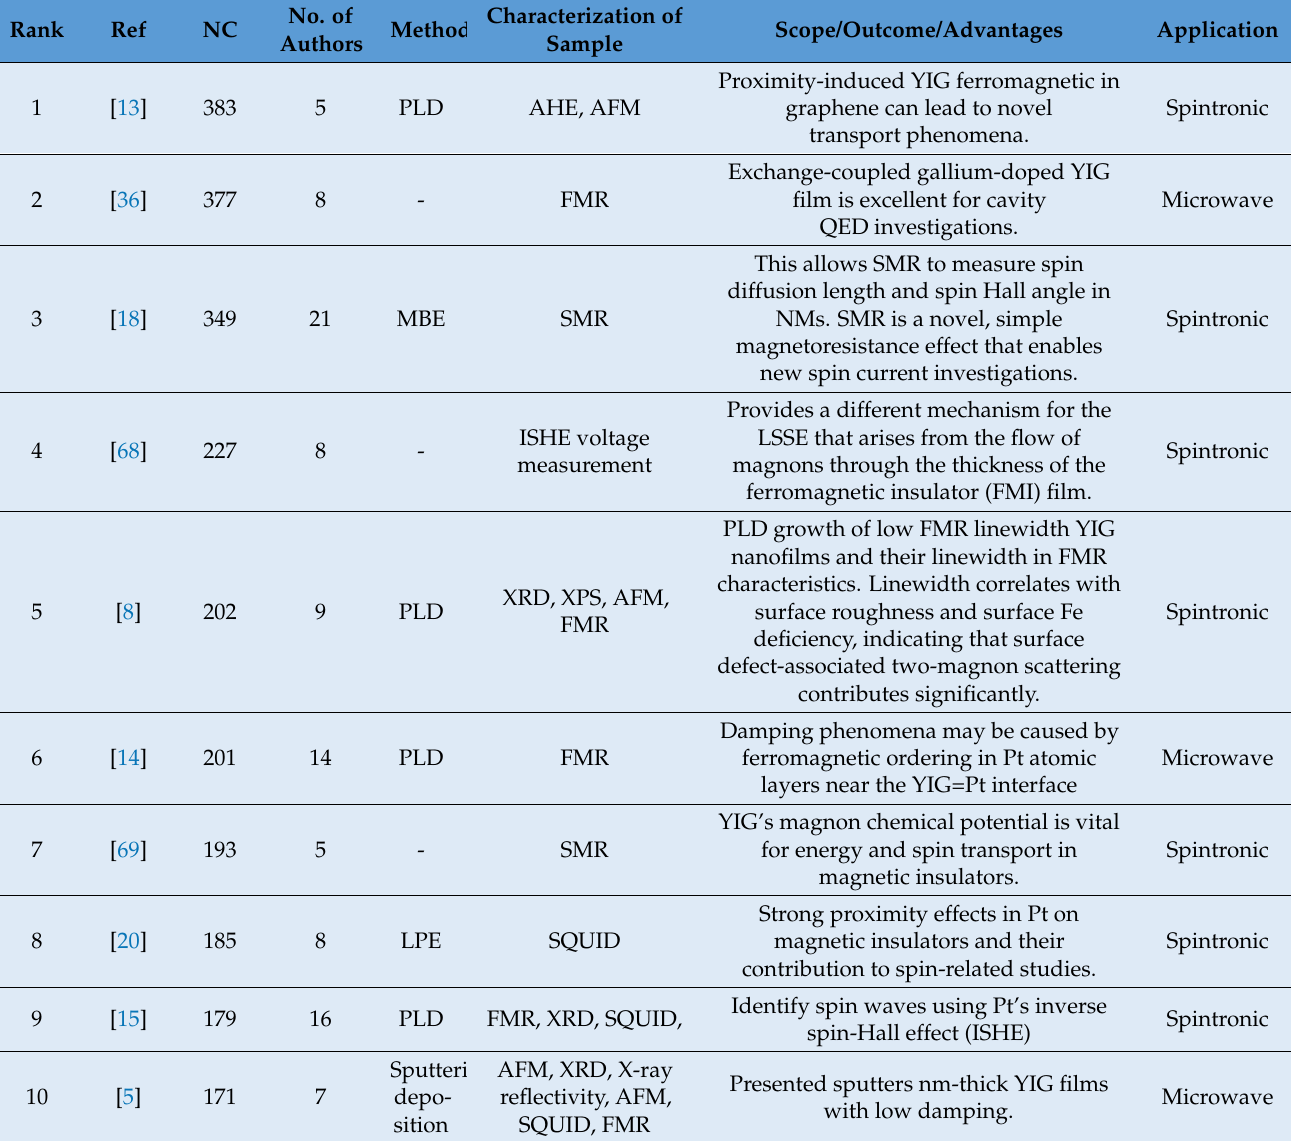
Table 2. The top ten most-cited papers in the field of